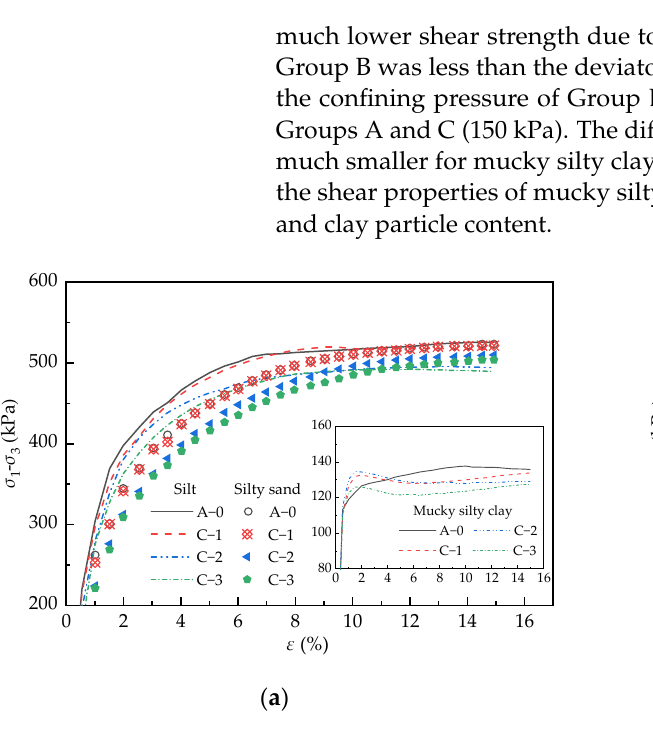
Figure 5. Deviator stress–strain relationship of soil under different stress paths. ( a ) Groups A and C; ( b ) Group B. Table 4. Final deviator stress of soil under different stress paths (Unit: